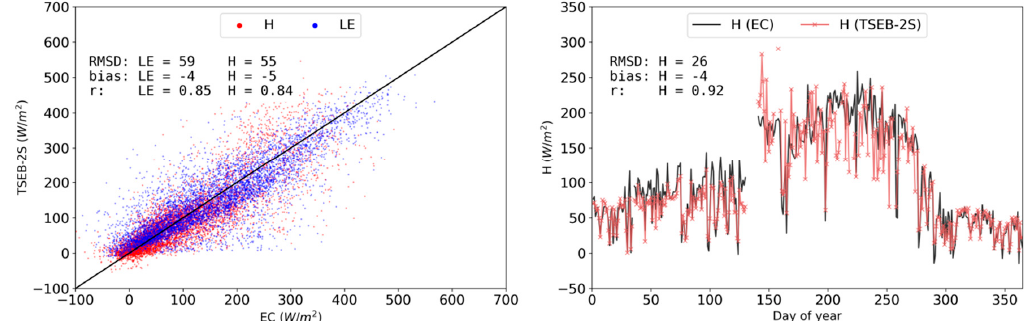
Figure 7. Observed vs modeled half-hourly daytime H (red) and LE (blue) density scatterplot for TSEB grass (left) and TSEB tree (right) for 2015 at CT.